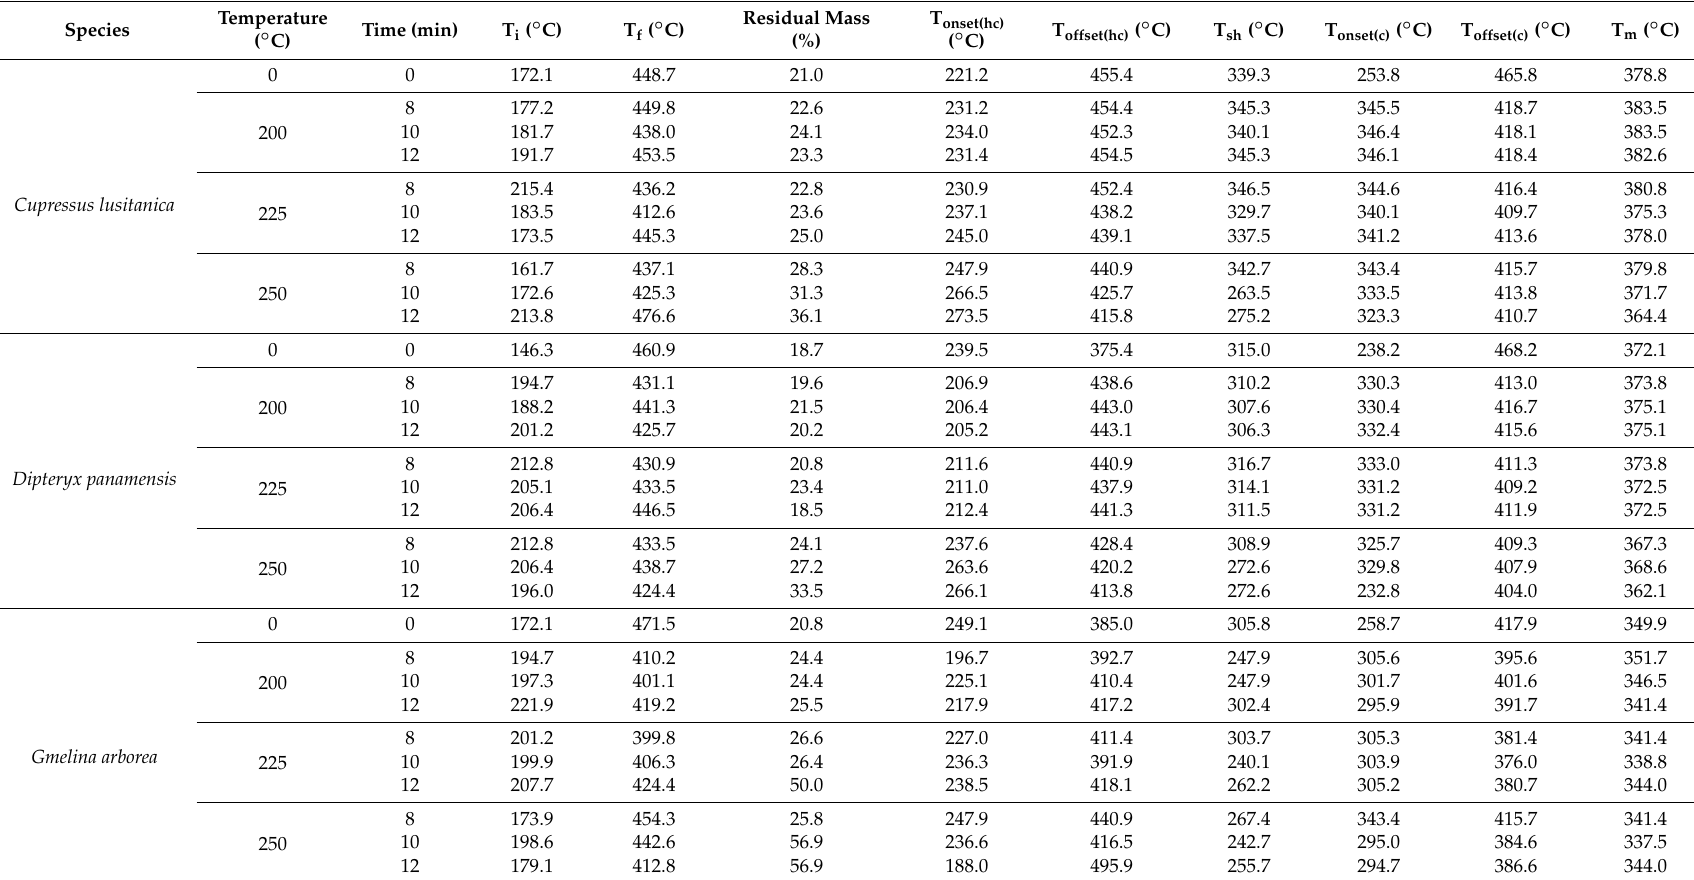
Table 2. Thermogravimetric analysis (TGA) temperatures of biomasses of five fast-growth plantation species in Costa Rica torrefied at different times and temperatures. Species